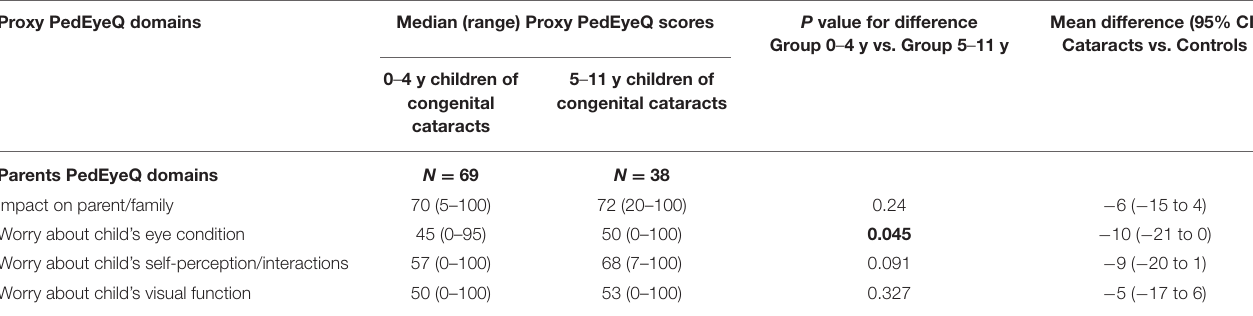
Bold values indicate significant difference between two groups. y = years